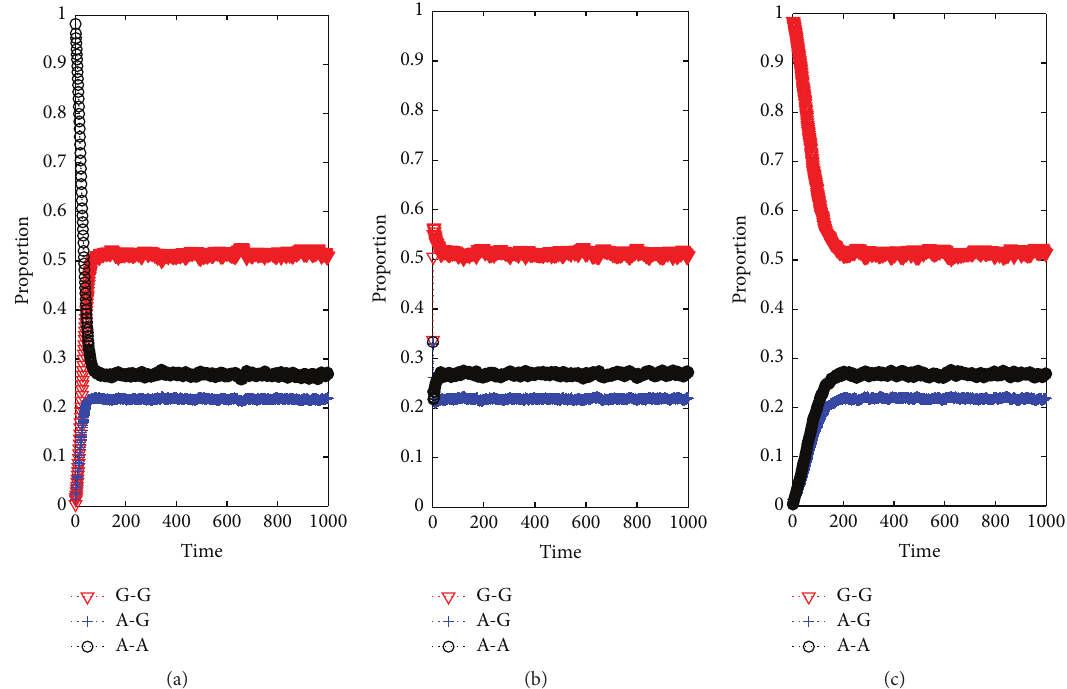
Figure 4: The evolution for the proportion of links (G-G, G-A, and A-A) with initially different G: A ratios (a) 1: 100, (b) 1:1, and (c) 100: 1.